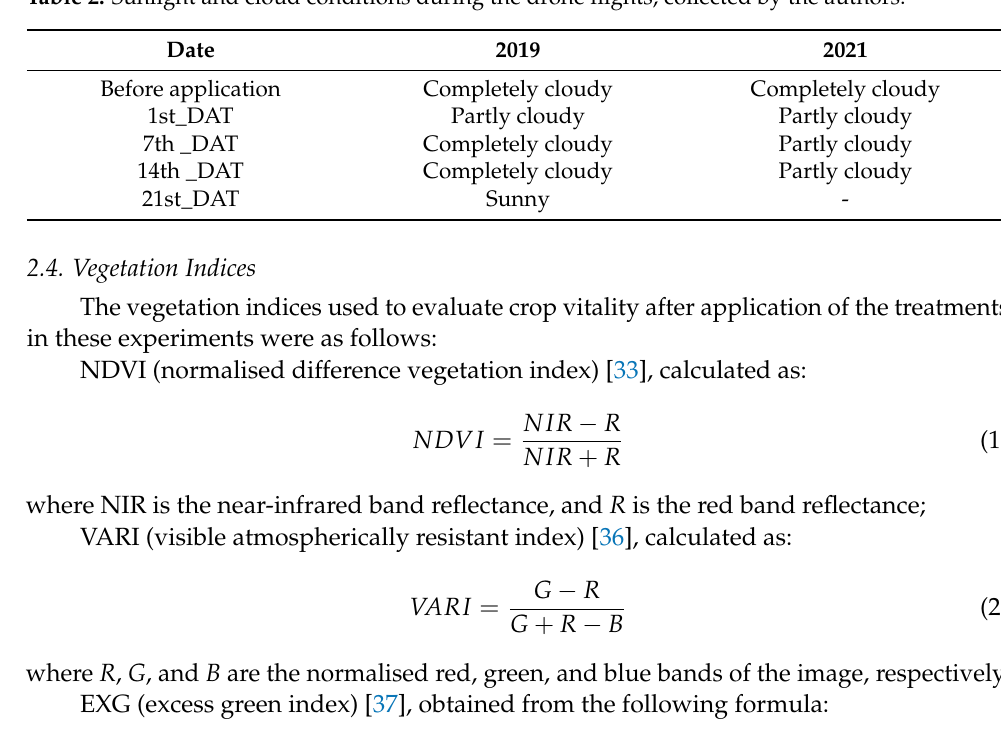
Table 2. Sunlight and cloud conditions during the drone flights, collected by the